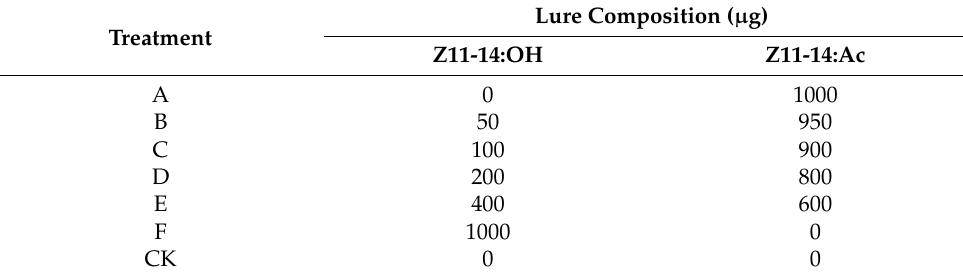
Table 1. Archips strojny sex pheromone lure baited with (Z)-11-tetradecenyl alcohol (Z11-14:OH) and (Z)-11-tetradecenyl acetate (Z11-14:Ac) for field trapping.